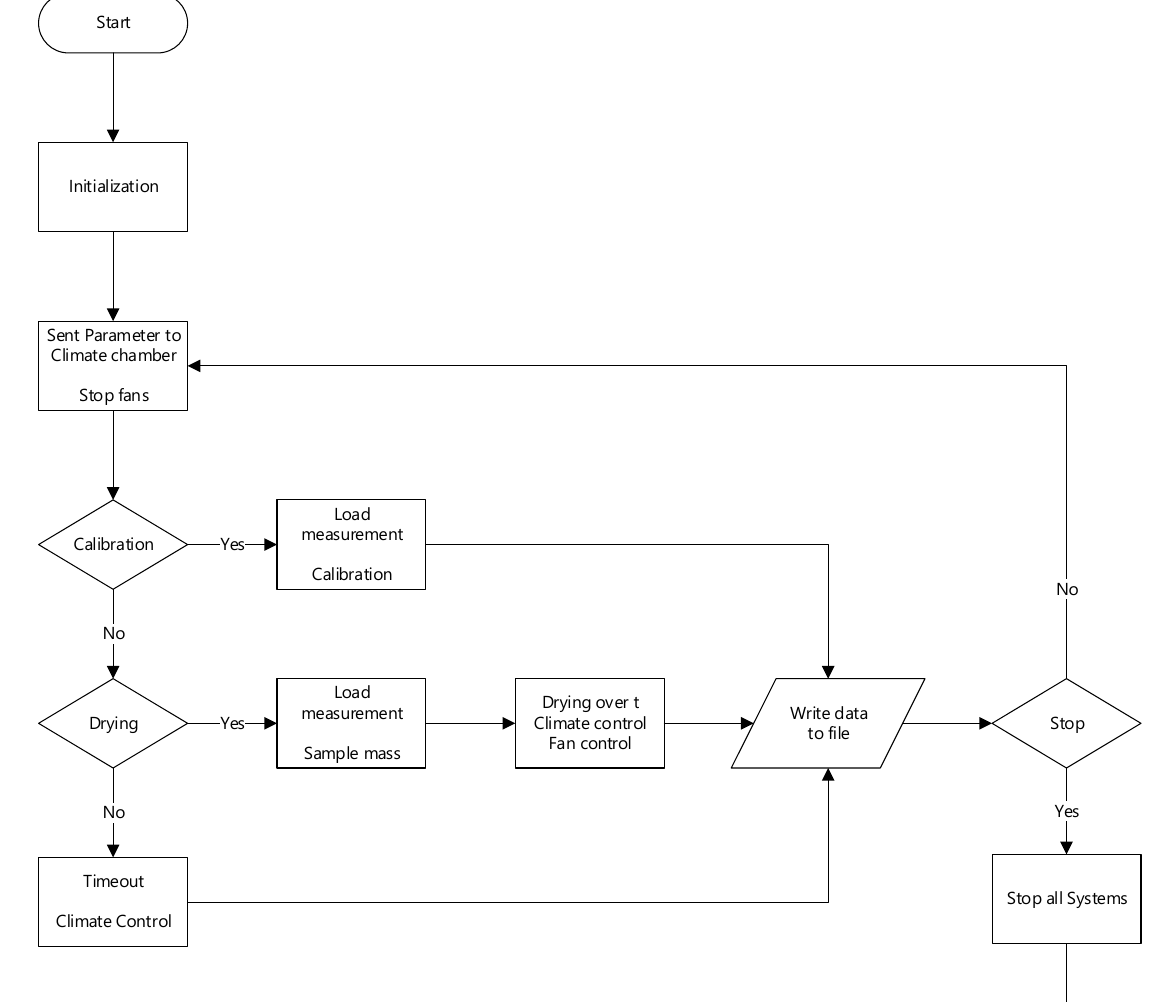
Figure 3. Schematic flowchart of HPD TP3+ control software. For the weighing process, all fans are stopped until the vane anemometers show zero velocity, and the sample trays are lifted in a freely suspended position. A break of 5 s is